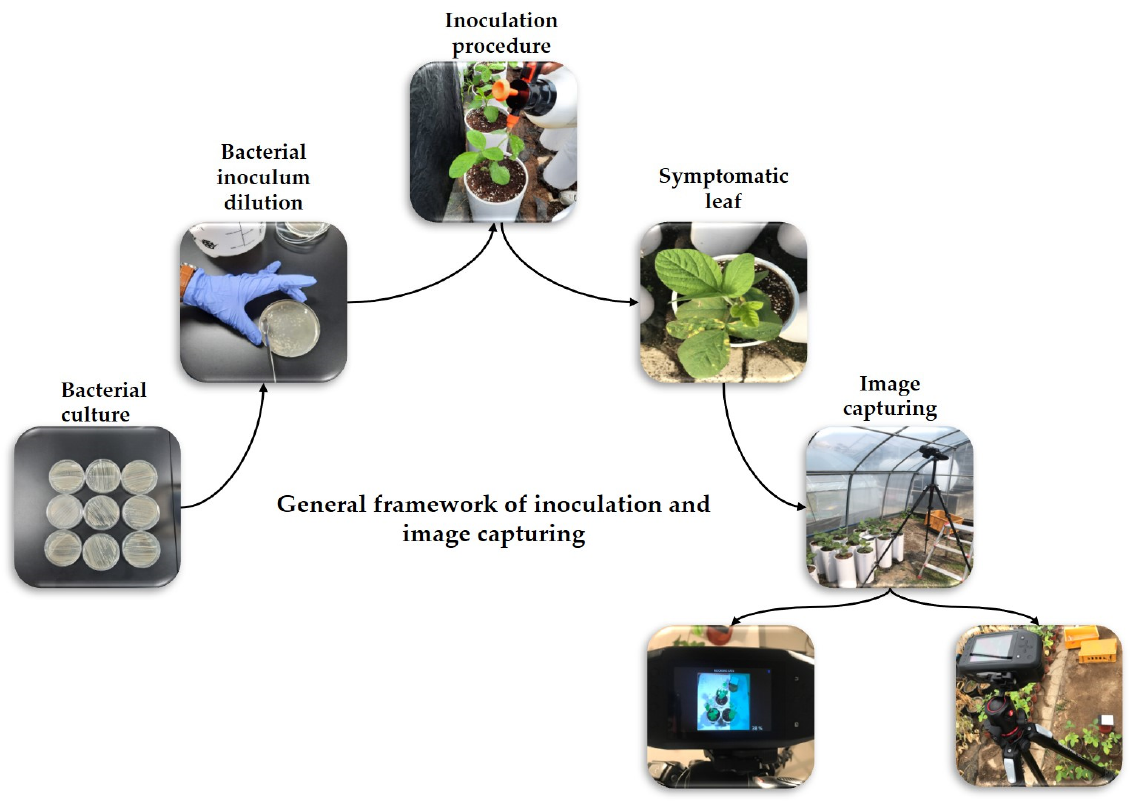
Figure 3. Inoculation procedure and image capturing of soybean plants.